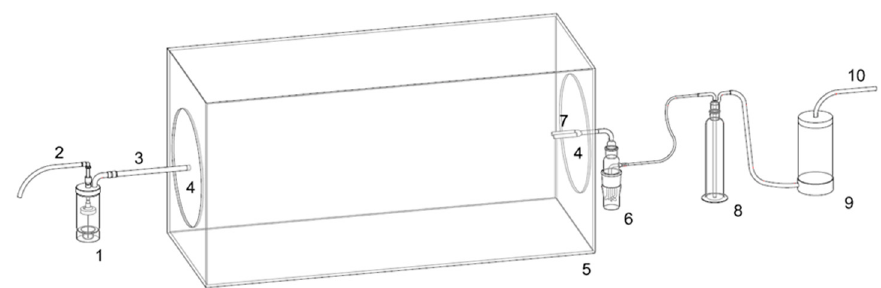
Figure 1. 1. CH-Technology BLAM aerosol generator; 2. Connection to compressor (TCR-TECORA Aero Particle Generator) 3. tube connection to 5. Bioaerosol Chamber: 4. side circular bioaerosol chamber closures; 6. SKC BioSampler; 7. Y shape bioaerosol inlet (internal to the bioaerosol box); 8. NaClO trap; 9. Air desiccator/drier; 10. connection to pump (TCR-TECORA BioBravo) .